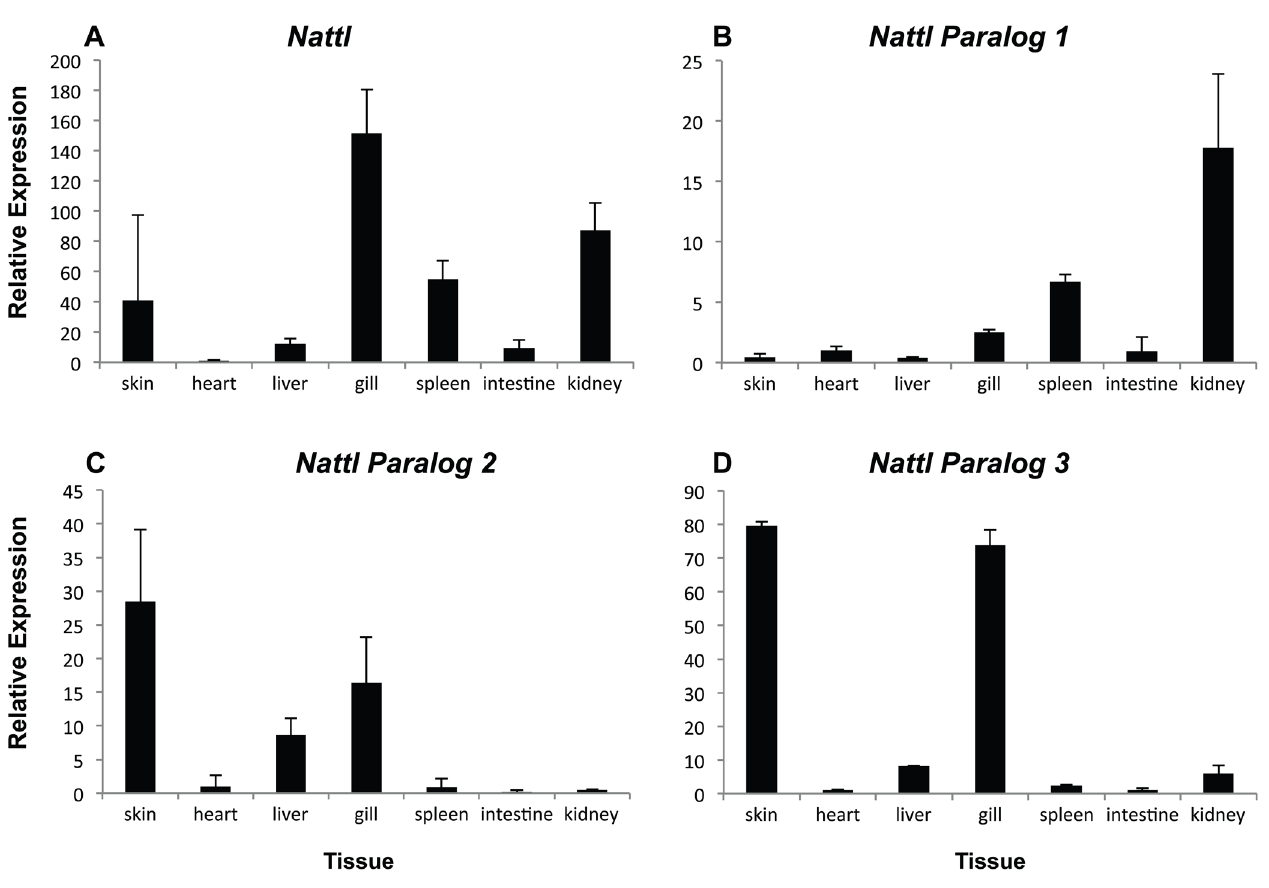
S1 Figure. Relative expression of nattl and nattl 1–3 in tissues of adult AC-charr. Relative expression of Natterin ( A ) & Natterin paralogs 1–3 ( B – D ) within different tissues (skin, heart, liver, gill, spleen, intestine & kidney) of adult aquaculture charr (RT-qPCR); expression plotted for different tissues, relative to heart tissue (lowest expression